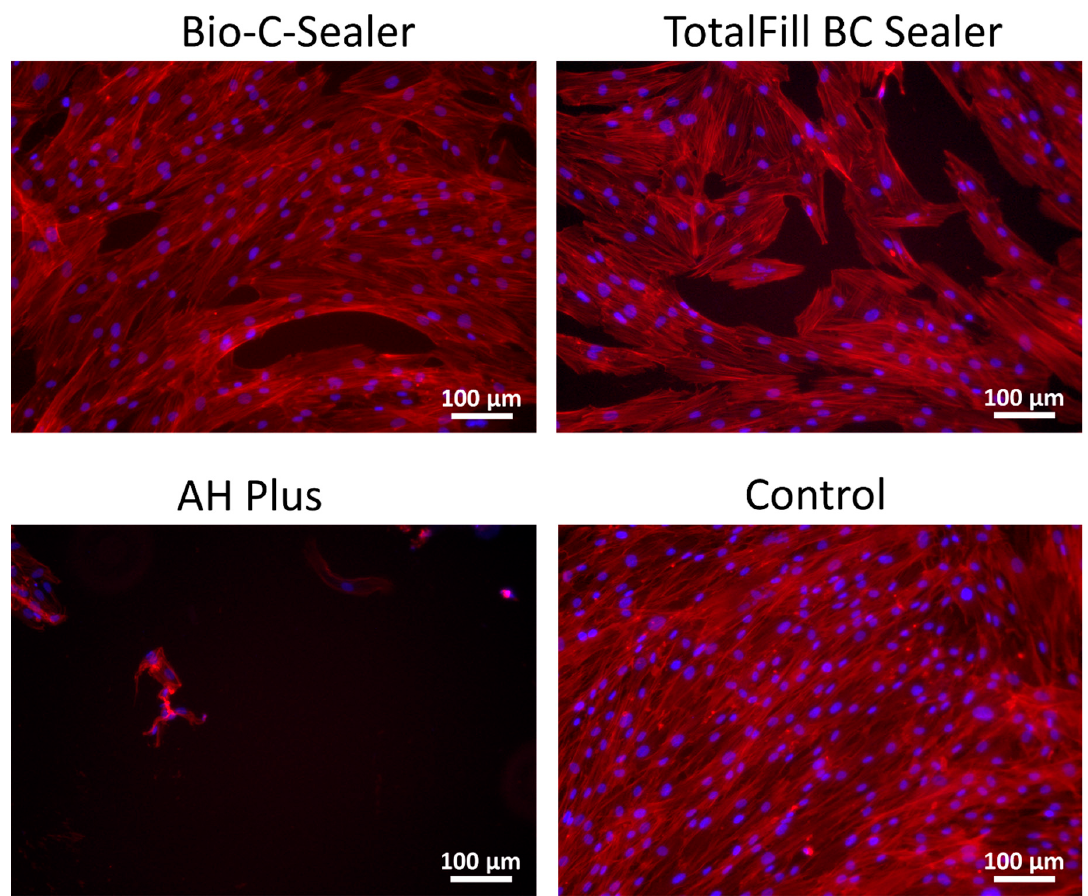
Figure 3. Morphological aspects of hPDLSCs cell cultures exposed to the undiluted extracts of Bio-C Sealer, TotalFill BC Sealer and AH Plus in culture medium. Blue fluorescence (DAPI) indicates cell nuclei, and red fluorescence (phalloidin), the actin cytoskeleton. Scale bar = 100 μ m.